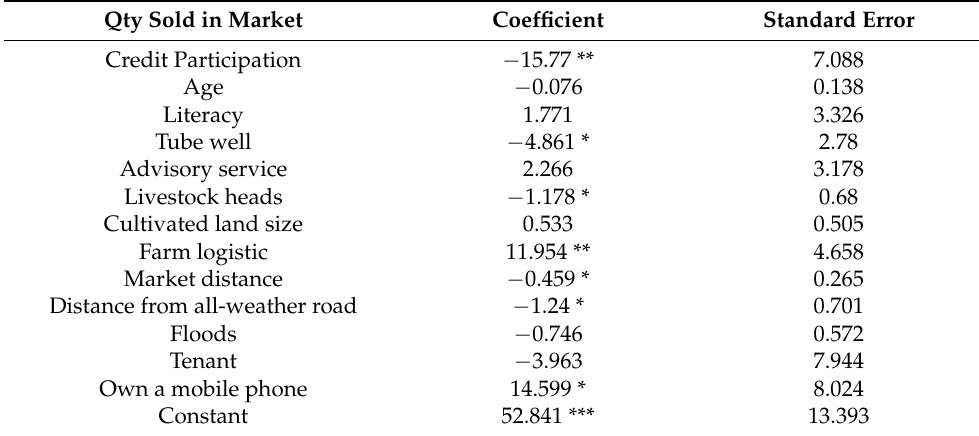
Table A3. Full table of IV estimate of first-period credit and market participation.